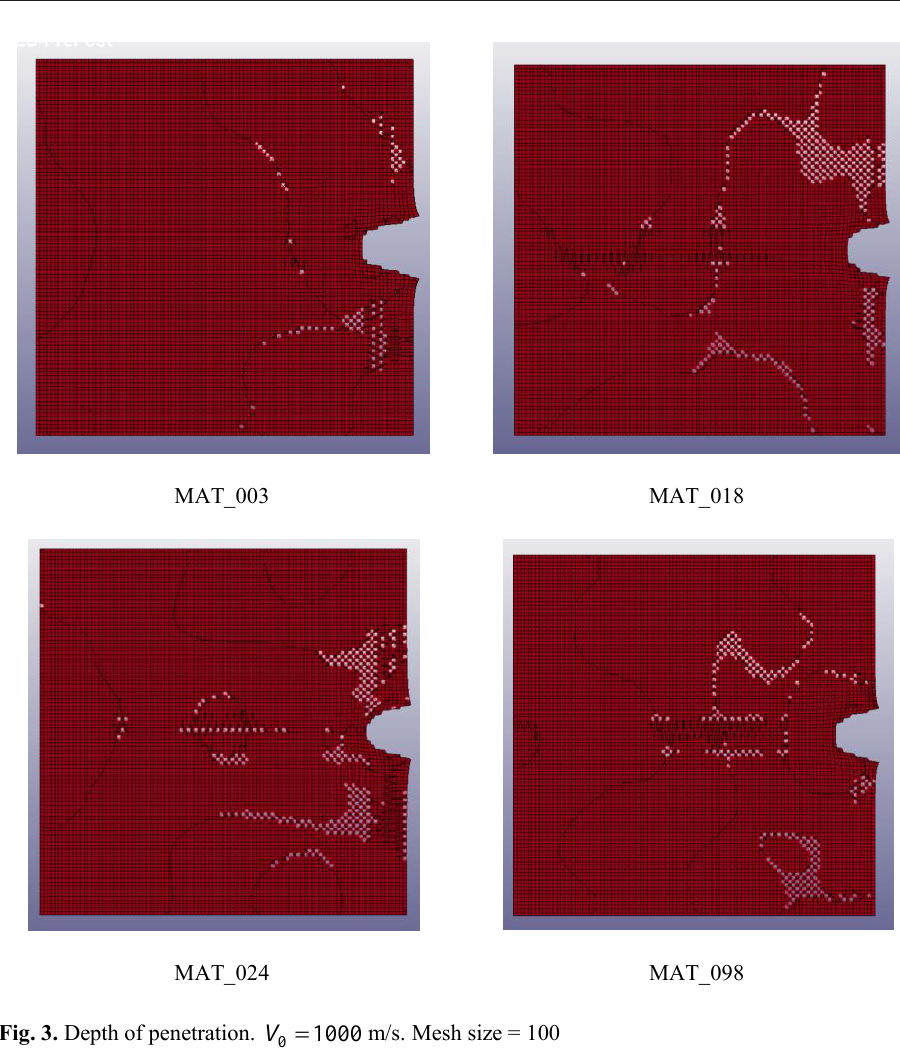
Fig. 3. Depth of penetration.